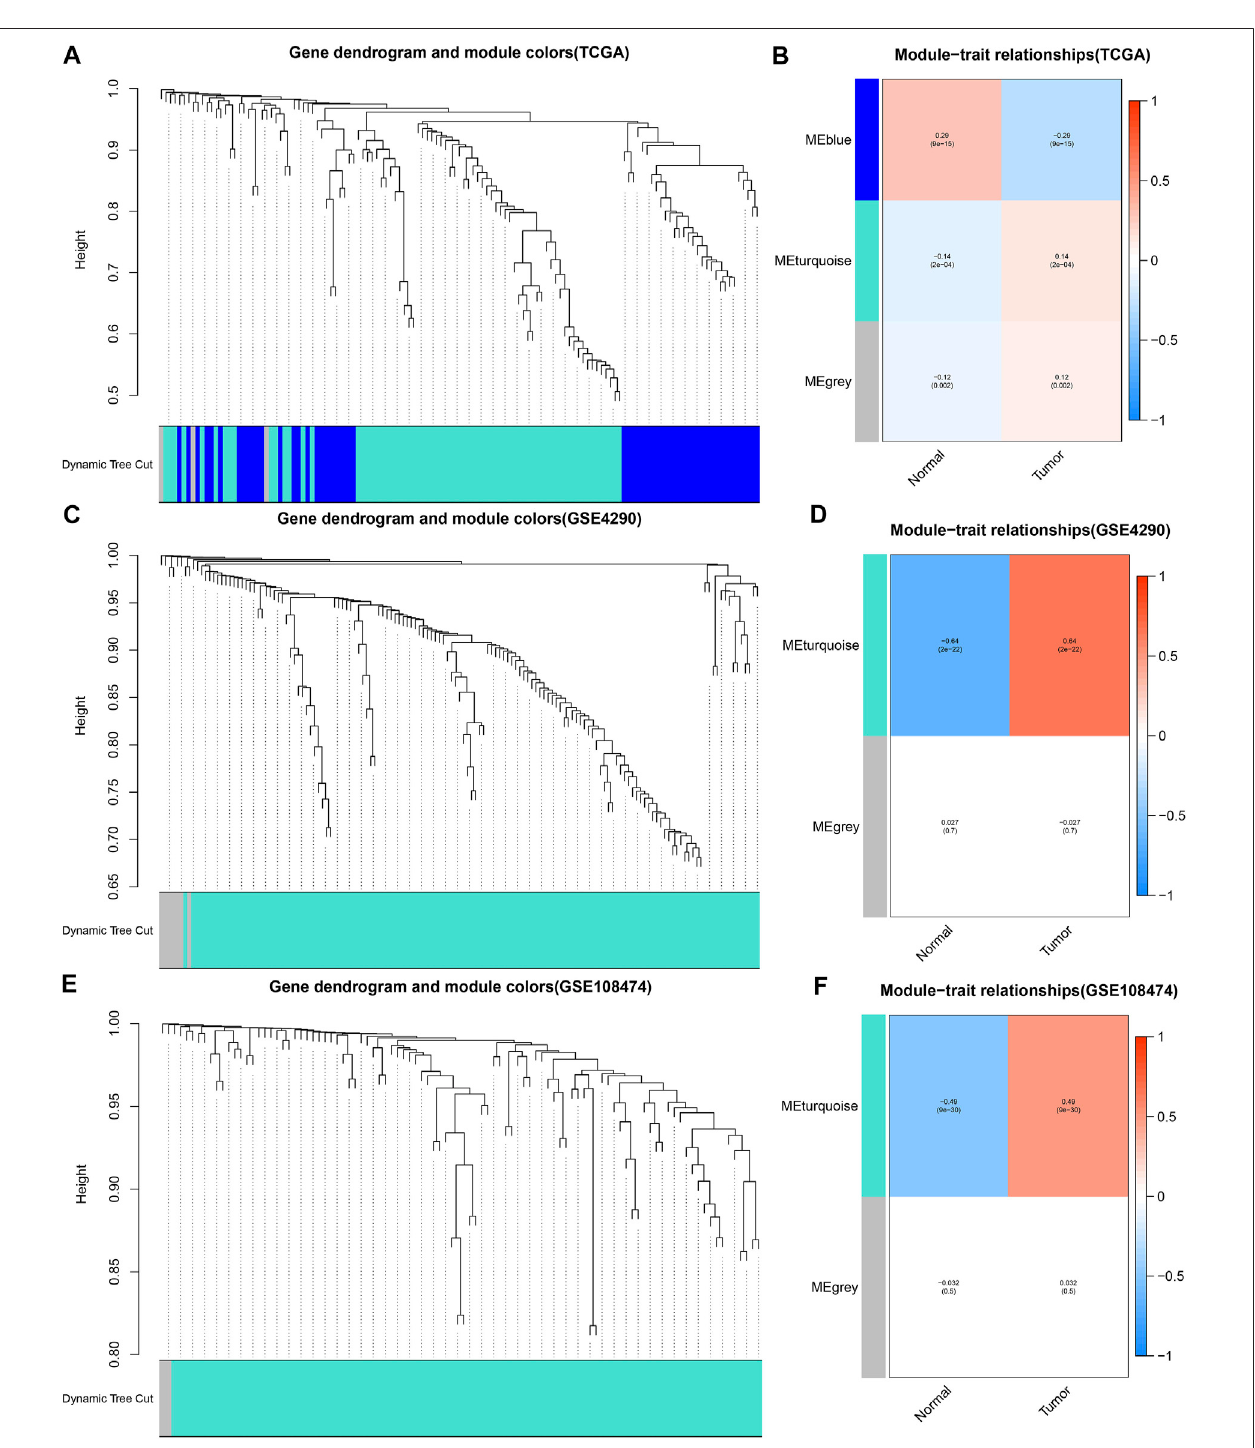
FIGURE 3 | Merged dynamic pruning trees and heatmaps of TCGA, GSE4290, and GSE108474 cohorts. (A , C , E) Dynamic pruning trees merging similar gene modules into one gene module. (B , D , F) Heatmaps showing correlation between gene modules and tumor status. The color label on the left is followed by the corresponding module. The two squares after the gene modules shows the correlation coef fi cients and p values between the gene modules and normal/tumor status, respectively.